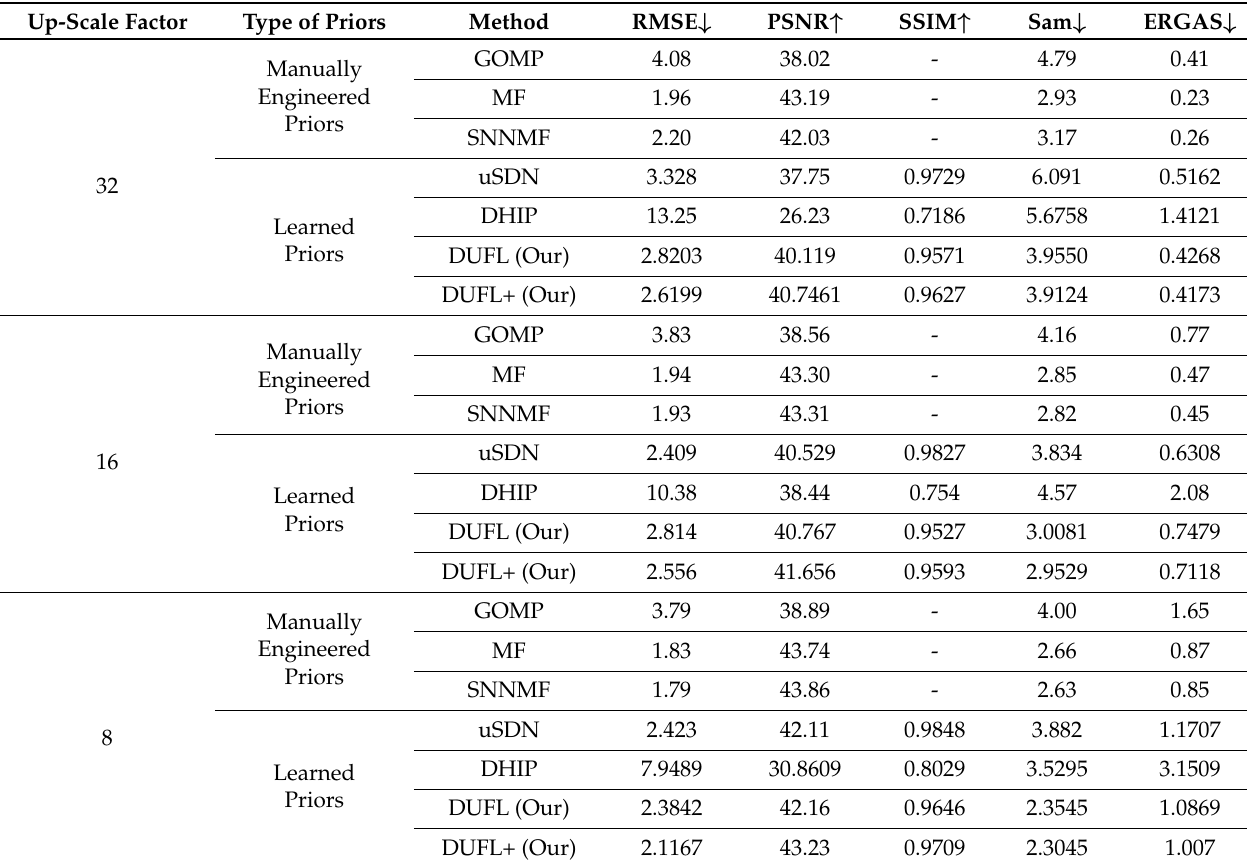
Table 3. Comparison of the evaluation results using the proposed methods with those obtained using the unsupervised SoTA methods, including the manually engineered image priors (GOMP [50], MF [16], SNNMF [51]) and automatically learned image priors (DHIP [24] and uSDN [41]) in the Harvard dataset for up-scale factors of 32, 16, and 8.